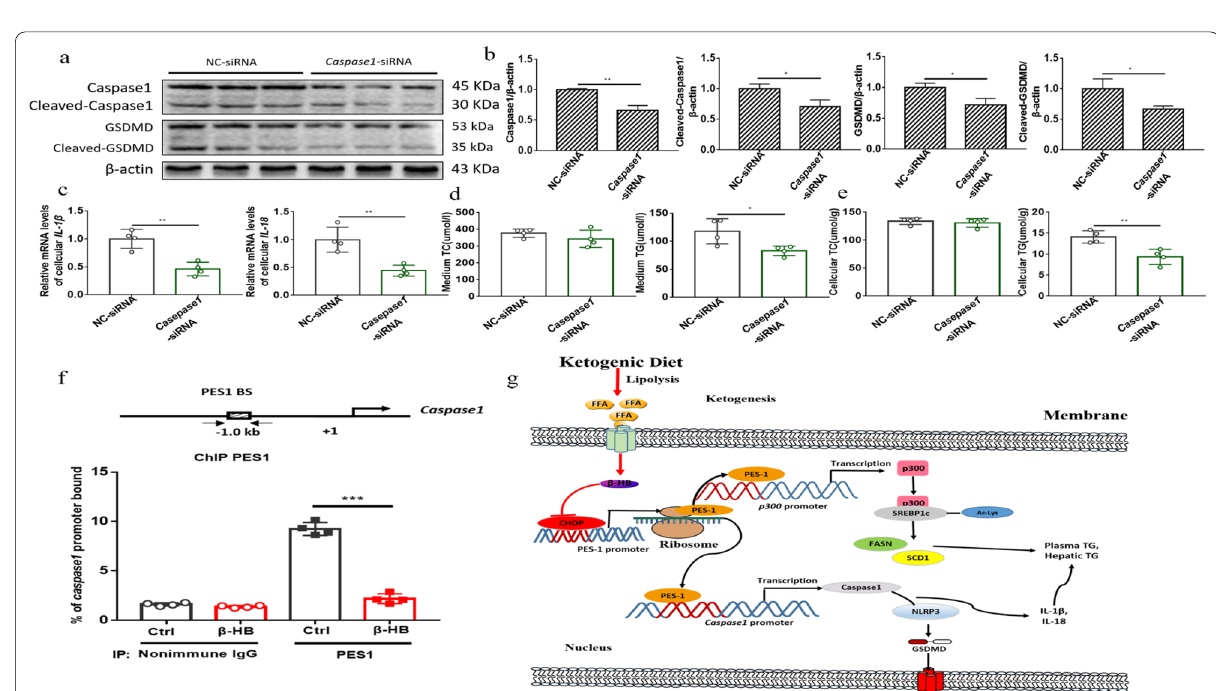
Fig. 8 β-HB lowered PES1 binding to the Caspase1 promoter and Caspase1 knockdown in hepatocytes reduced the medium and cellular TG. a , b Caspase1 knockdown in liver cells suppressed the inflammation proteins. c Shown are the effects of Caspase1 knockdown on the relative mRNA levels of cellular IL-1β and IL-18 . d , e Caspase1 knockdown in liver cells reduced the medium and cellular TG. f β-HB decreased PES1 binding to the Caspase1 gene promoter. g Schematic diagram of the entire study. Data were shown as mean SEM for each experiment performed independently ± 3 times. *P < 0.05, **P < 0.01, ***P < 0.001 compared with control (Student’s t